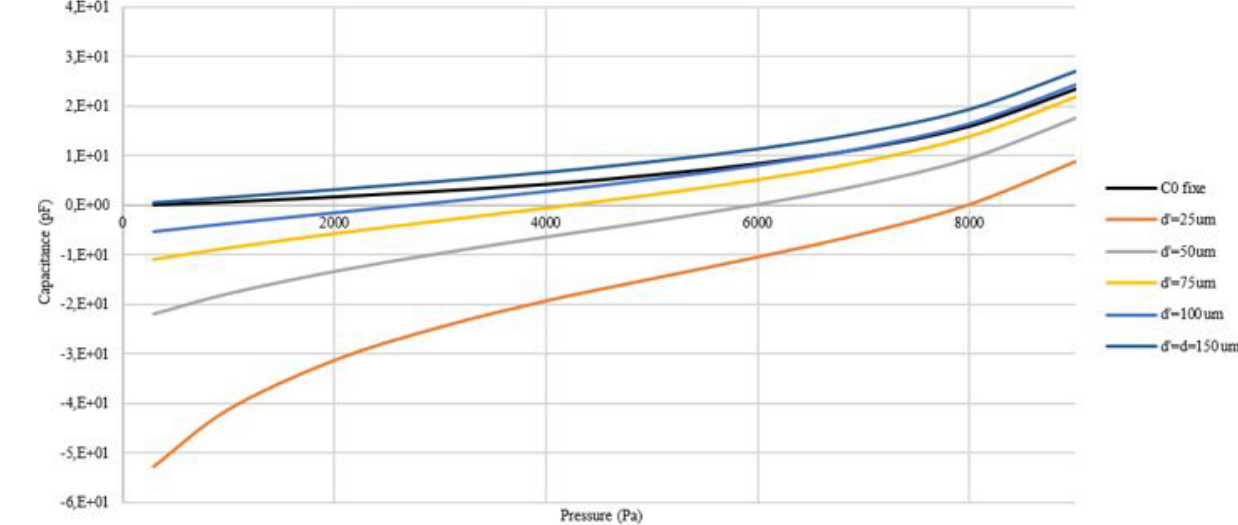
Figure 4. Sensor response for different d i values compared to the response of the traditional design for which C 0 is fixed.